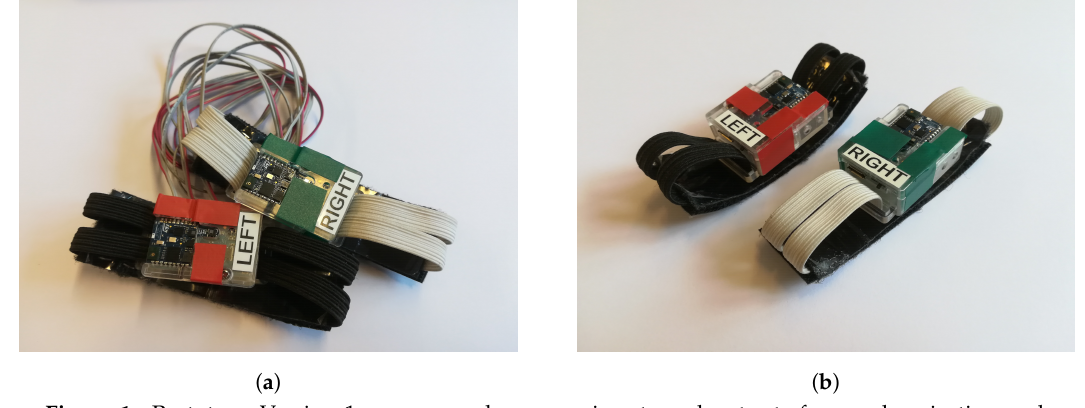
Figure 1. Prototype Version 1 uses general purpose inputs and outputs for synchronisation and labeling, hence a button for each board and a wire to connect the wearable on each wrist were necessary. For version 2 there was no further need for this. ( a ) Prototype Version 1, ( b ) Prototype Version 2. Table 1. Settings of the Sensors on the STEVAL-STLKT01V1 for the